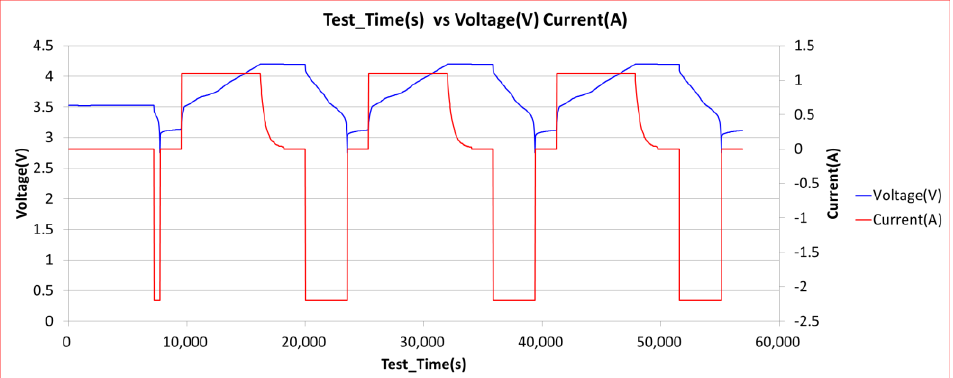
Figure 1. Capacity testing process.